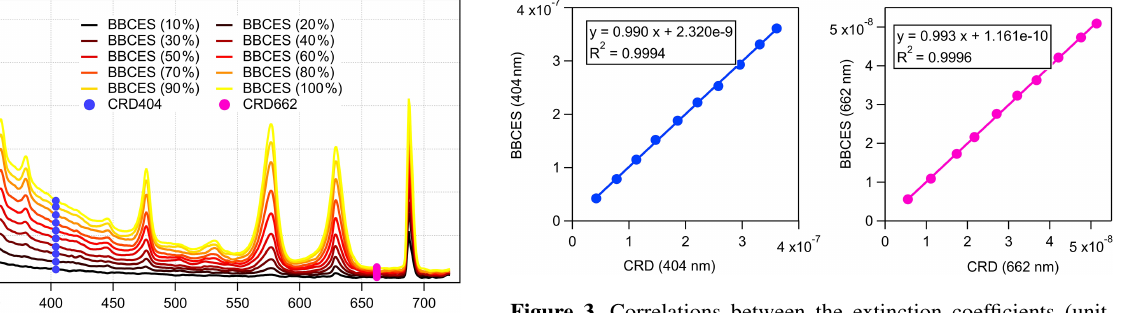
Figure 3. Correlations between the extinction coefficients (unit, cm − 1 ) measured by the BBCES system and CRDS setup.